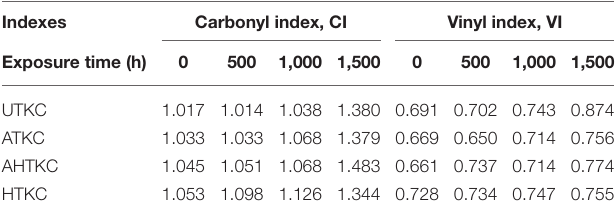
TABLE 2 | Characteristic FT-IR absorption peaks of composites. Corresponding functional group